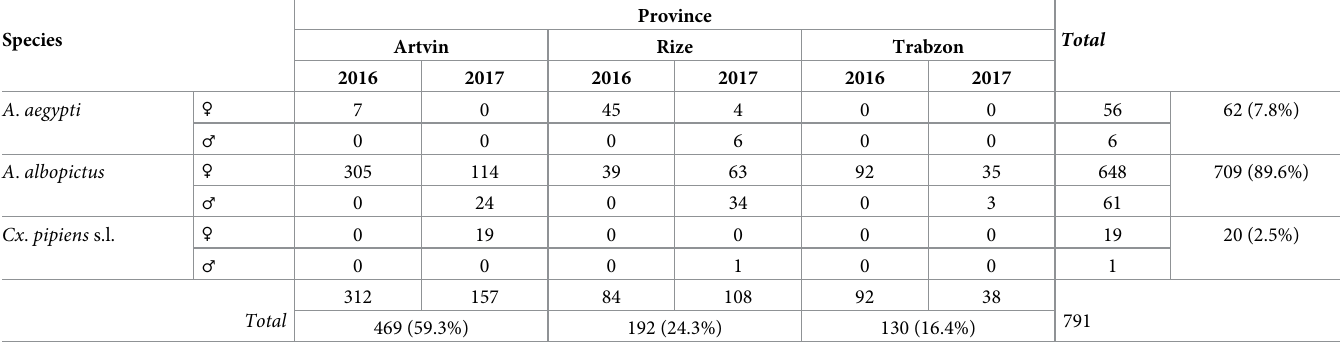
Table 1. Overview of the field-collected mosquito specimens used for virus screening.